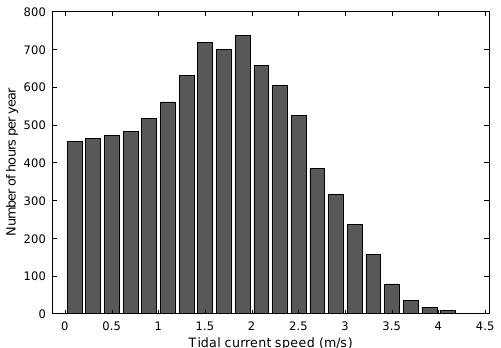
Figure A1. Tidal velocity distribution at EMEC site, Orkney [61].